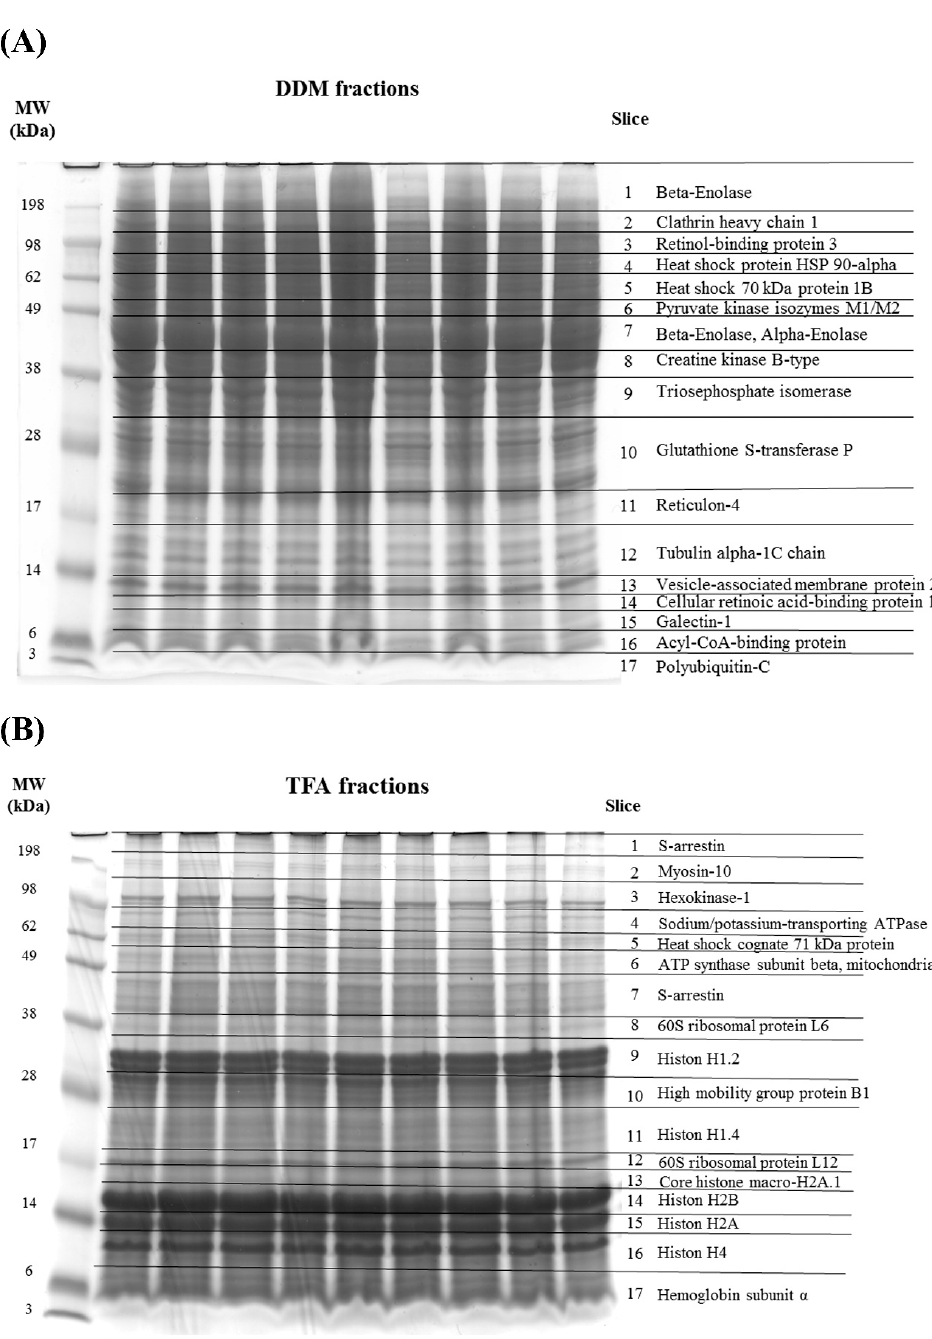
Figure 1. 1-D SDS PAGE of porcine retinal proteins after extraction with 0.1% dodecyl-ß-maltoside (DDM) or 1% trifluoroacetic acid (TFA) buffer labeled with the most abundant proteins per spot. Each sample lane contains a total protein amount of 50 µg. ( A ) Protein migration pattern of the 0.1% DDM extract mostly containing cytoplasm-derived or membrane-associated proteins. ( B ) Protein migration pattern of the 1% TFA extract predominantly consists out of nucleus-derived proteins.